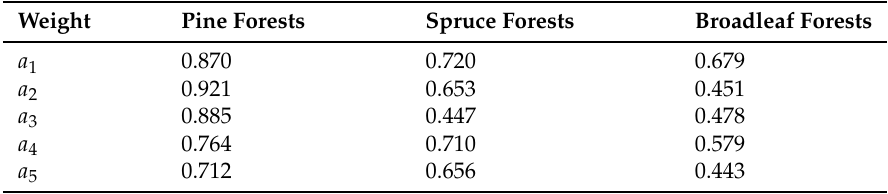
Table 2. Multiple correlation of inventory parameters and weights of basis functions.